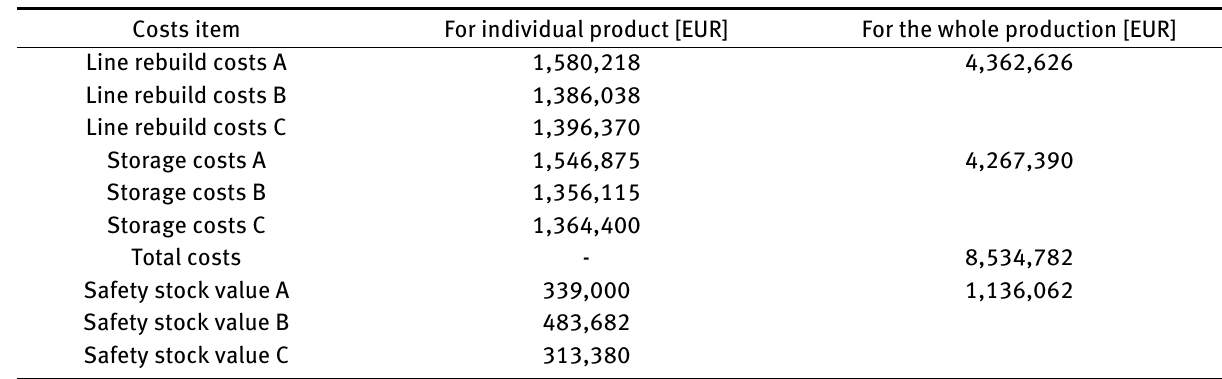
Table 7: Cost of production after